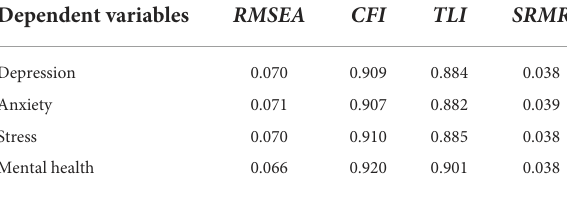
TABLE 4 Model fit results of the four